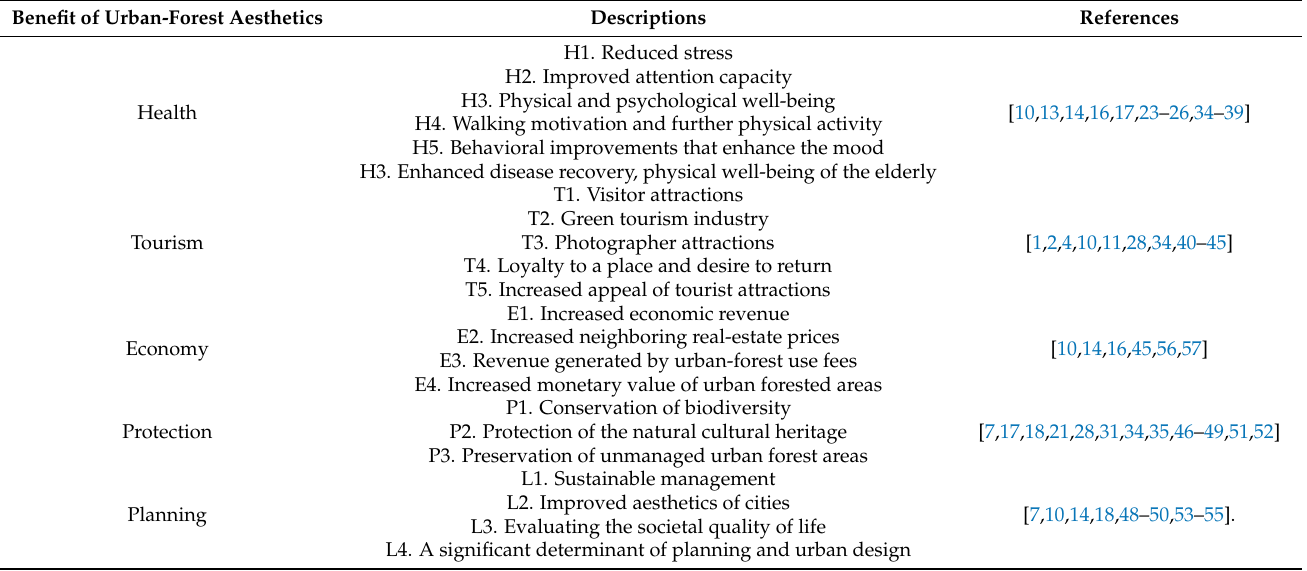
Table 1. Overview of benefits of urban-forest